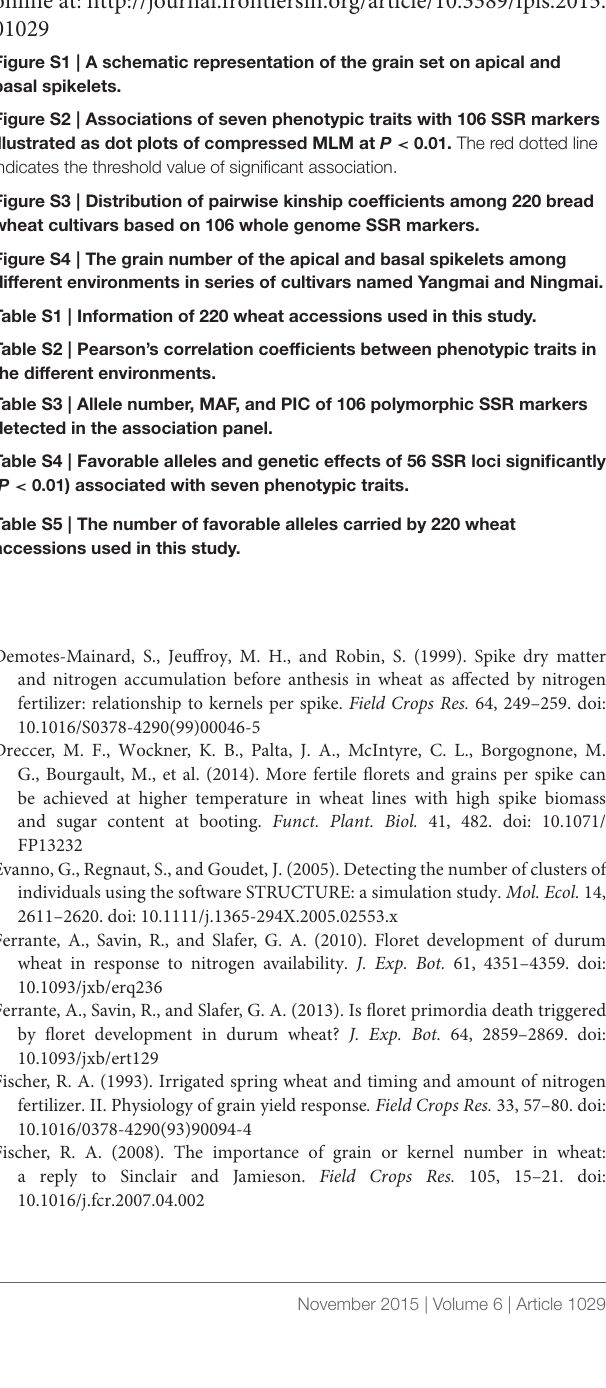
FIGURE 6 | Relationships between average grain-setting rates in apical and basal spikelets, and numbers of favorable alleles.